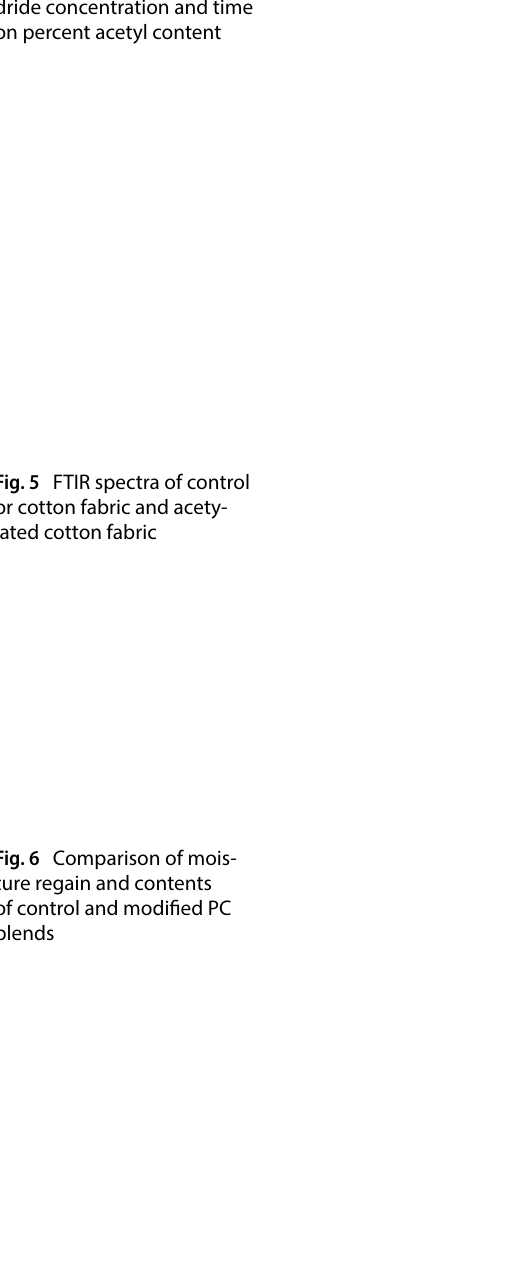
Fig. 4 Effect of acetic anhy- dride concentration and time on percent acetyl content